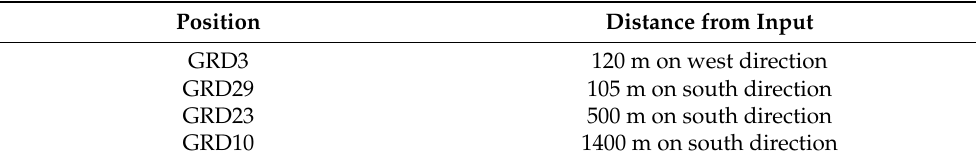
Table 4. Specific positions chosen in the CTD local scale grid (Figure 3) to evaluate vertical profiles at increasing distance from the fresh water